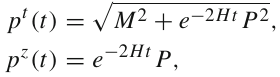
Fig. 1 Left: Numerical calculation of the normalisation factor N ( M , D , H ) . This plot shows the ratio N ( M , D , H )/ N ( M , D , 0 ) , where N ( M , D , 0 ) is the Minkowski-spacetime normalisation factor